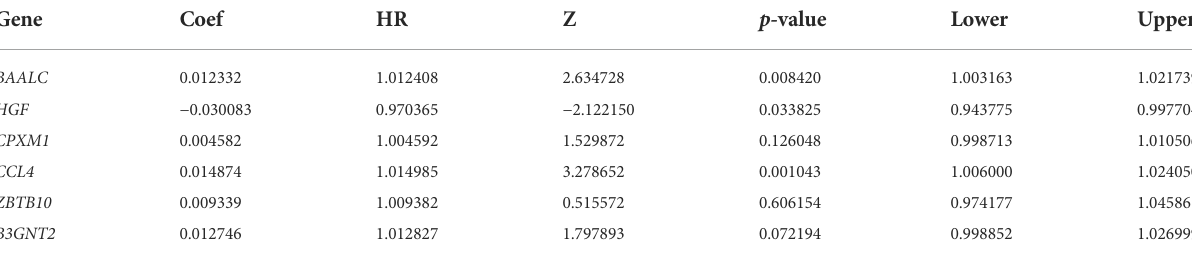
TABLE 4 Genes included in prognostic ALL genes